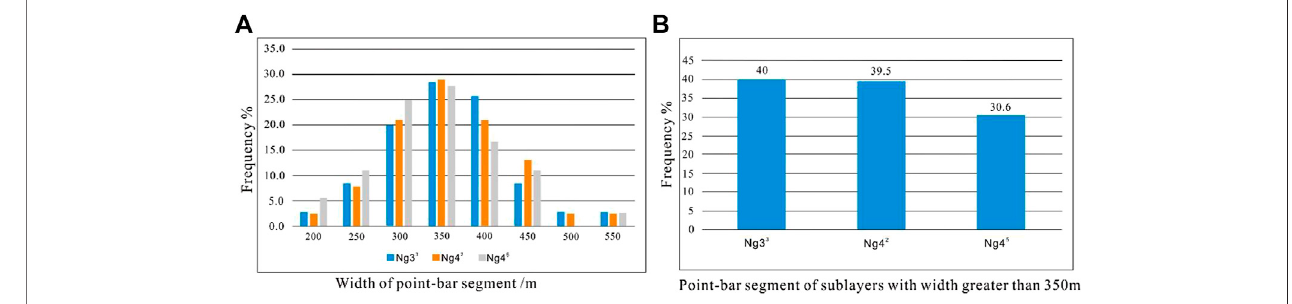
FIGURE 12 | (A) Histogram of the width of the identi fi able point bar segments and frequency. (B) Proportion of the width of the point bar segments greater than 350 m in different sub-layers.